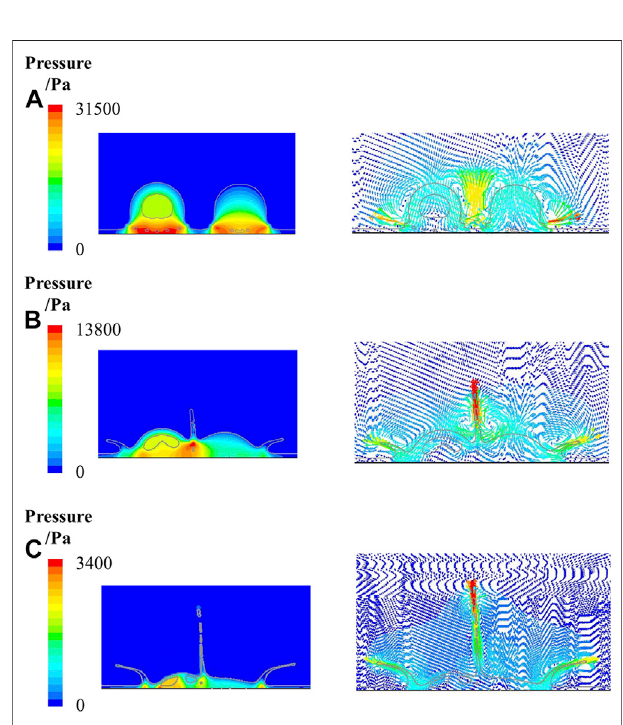
FIGURE 6 | Pressure and velocity distribution of droplets impact at different time instants: (A) 0.05 ms, (B) 0.2 ms, and (C) 0.5